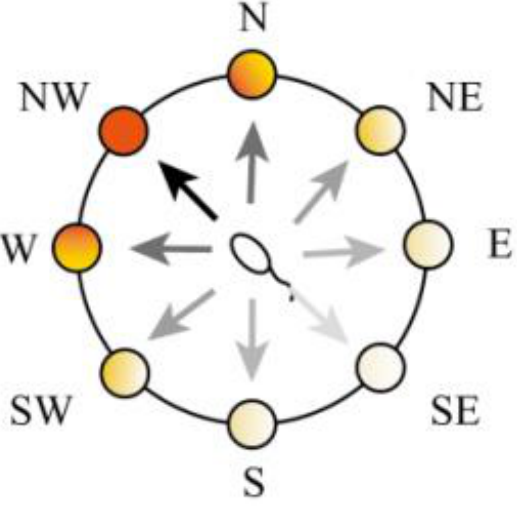
Figure 7. A schematic diagram of the action neurons.